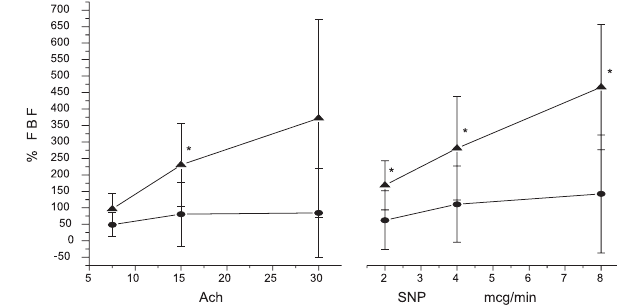
Figure 2 - Forearm blood flow increment (%) after Ach and SNP infusion in subjects with MS(·) and controls(²%). (* P <0.05 intergroup)